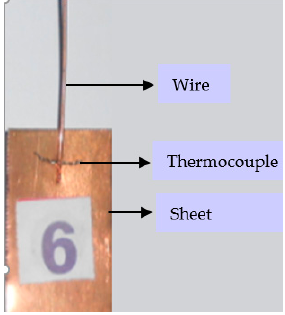
Figure 4. Thermocouple at the interface. Materials 2018 , 11 , x FOR PEER REVIEW